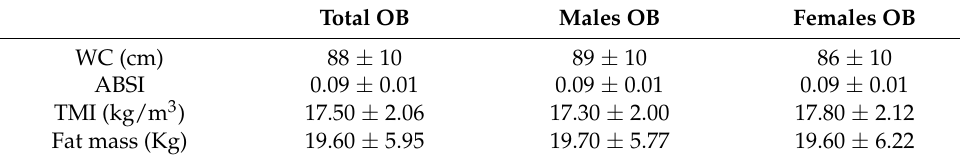
Table 2. Anthropometric characteristics of the children with obesity